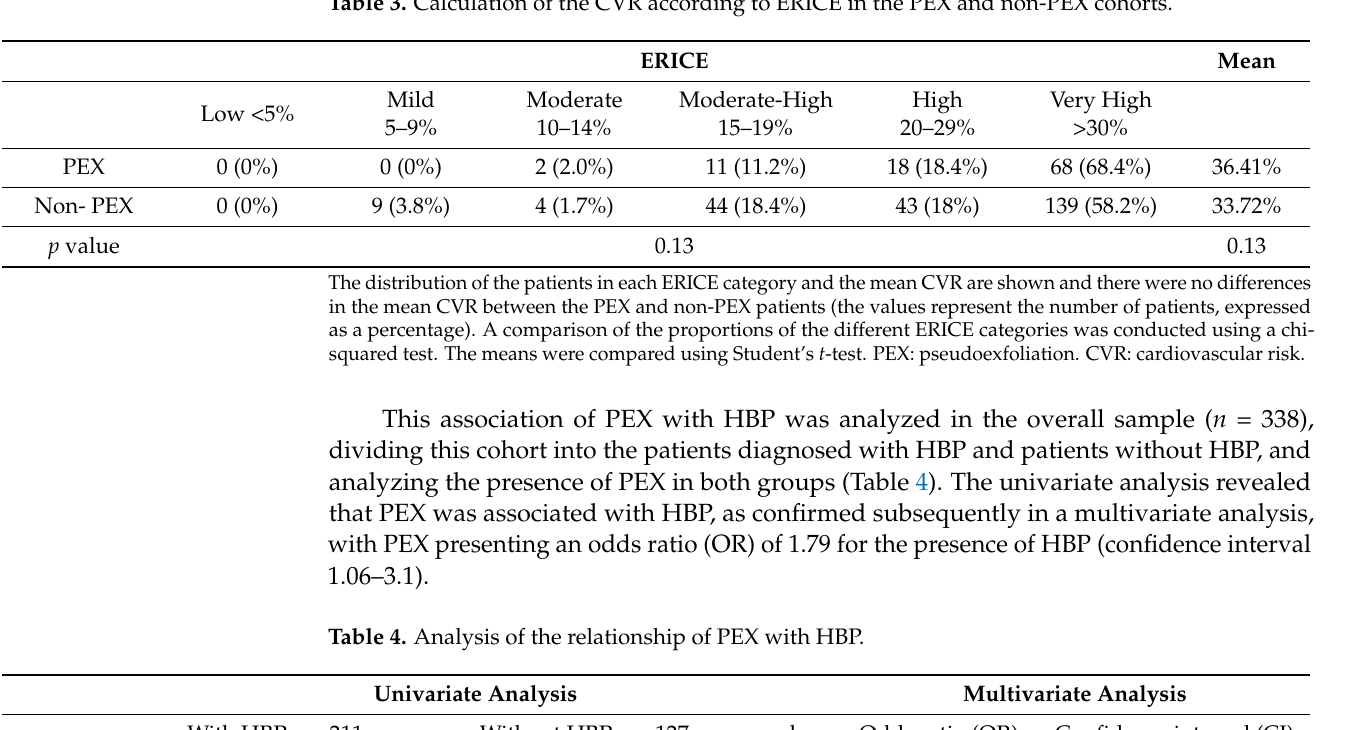
Table 3. Calculation of the CVR according to ERICE in the PEX and non-PEX cohorts.